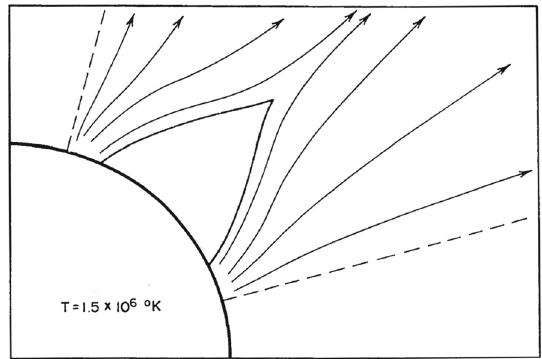
Fig. 10 Analytic solution of a helmet configuration.